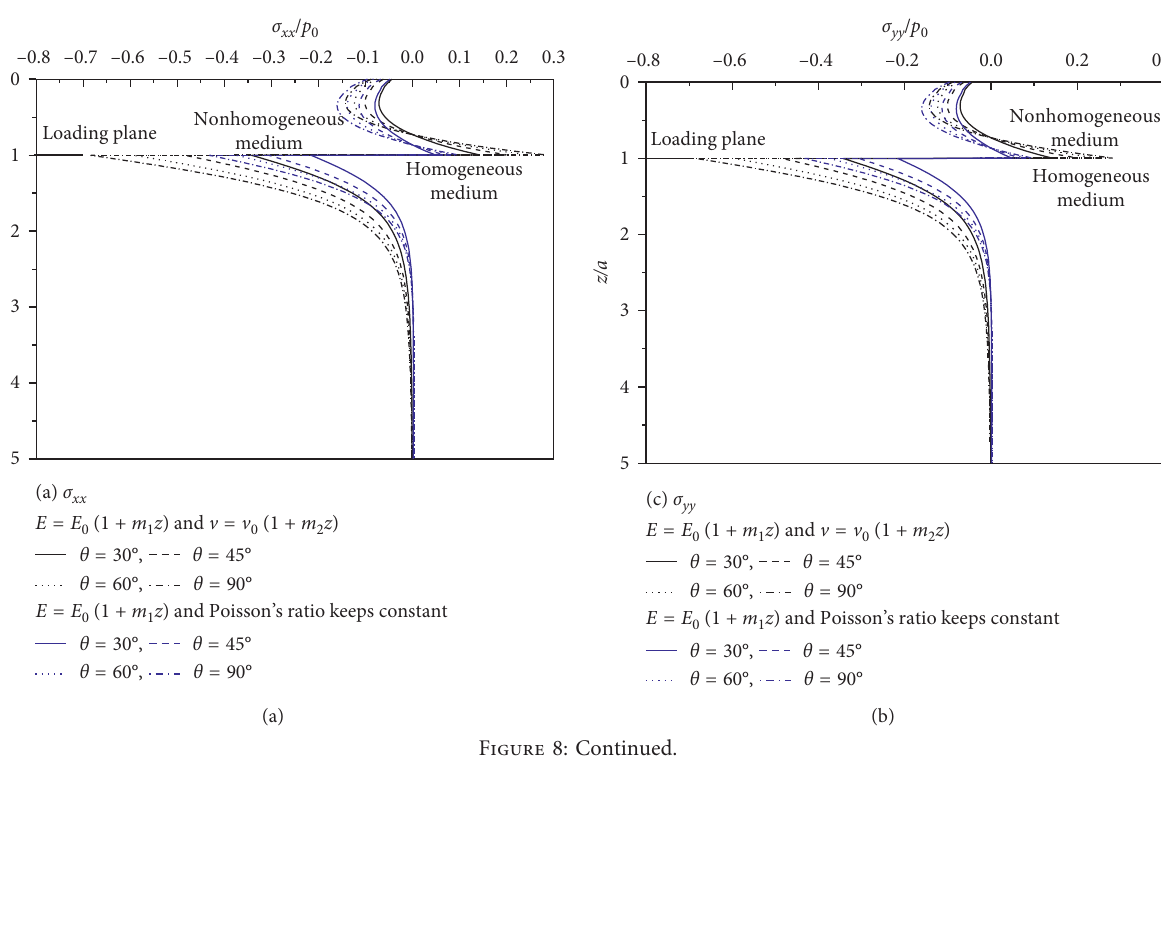
x E 0 / p 0 a ; (b) u z E 0 / p 0 a